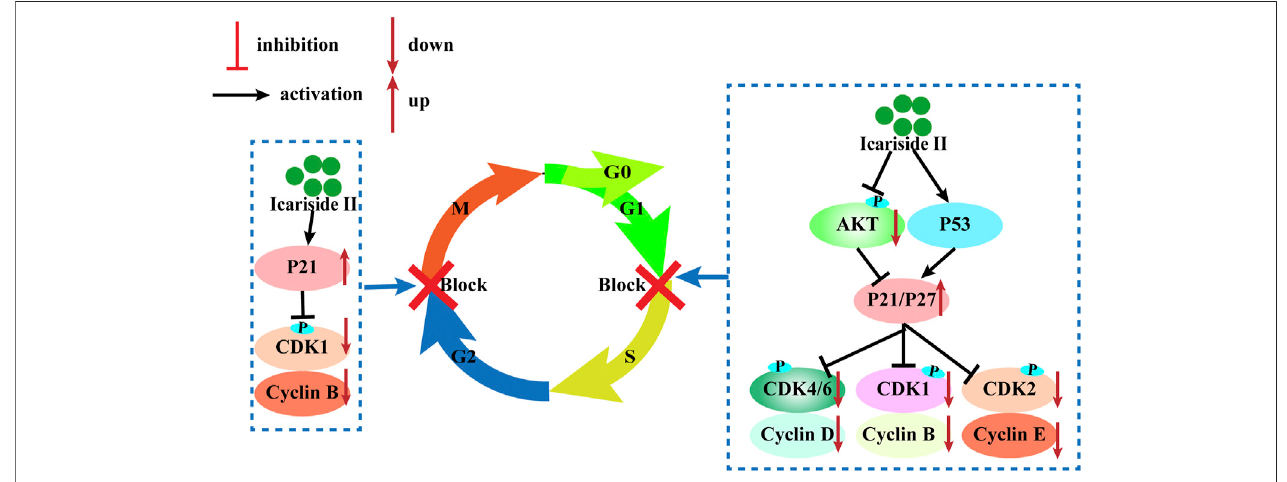
FIGURE 3 | Cell cycle arrest induced by Icariside